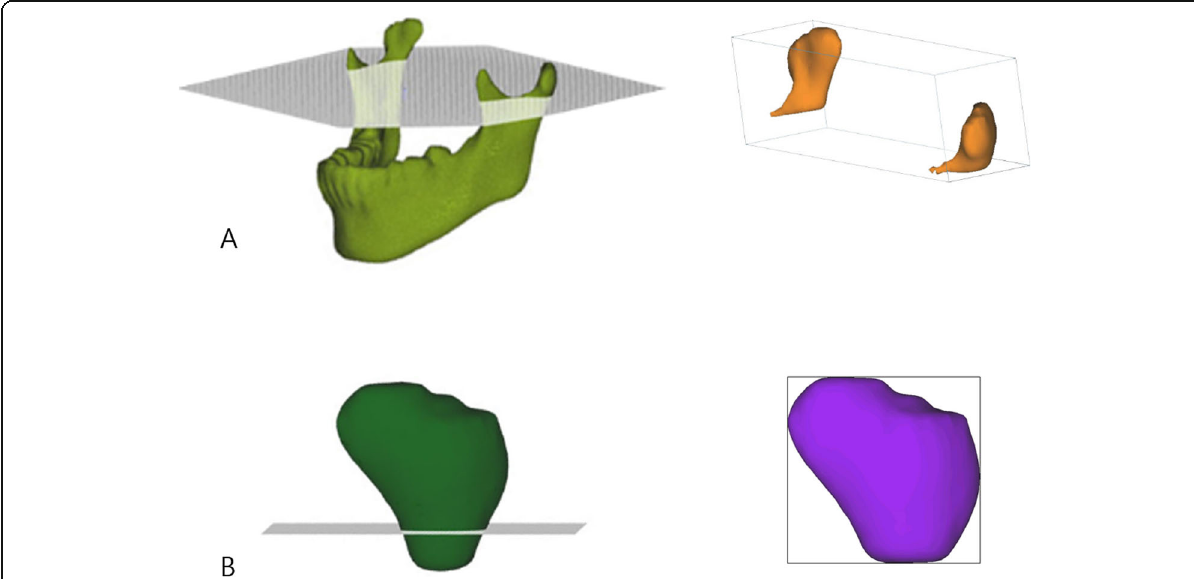
Fig. 1 Formation of three-dimensional images. The neck ( a ) and head ( b ) selection of demand (SOD) files were separated from the mandible SOD file that was separated from the whole volume rendering image by removing the overlapping areas using the sculpt functions of the V- works program (CyberMed Inc., Seoul, Korea) (reproduced with permission